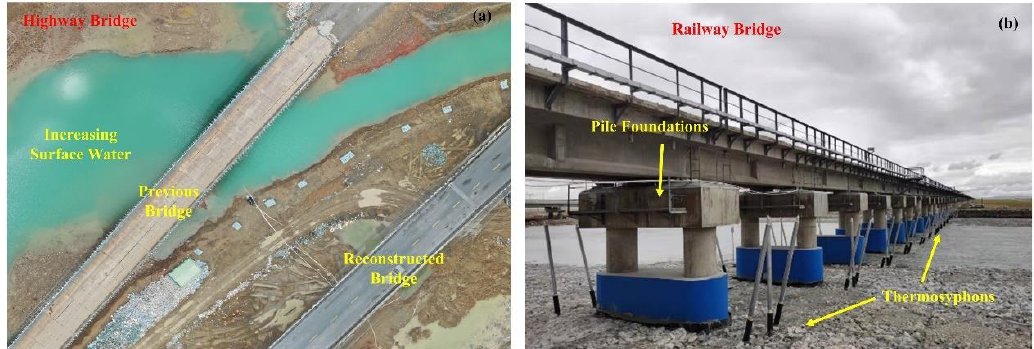
Figure 14. Countermeasures used by the ( a ) highway and ( b ) railway downstream to cope with flowing water drained from Salt Lake.